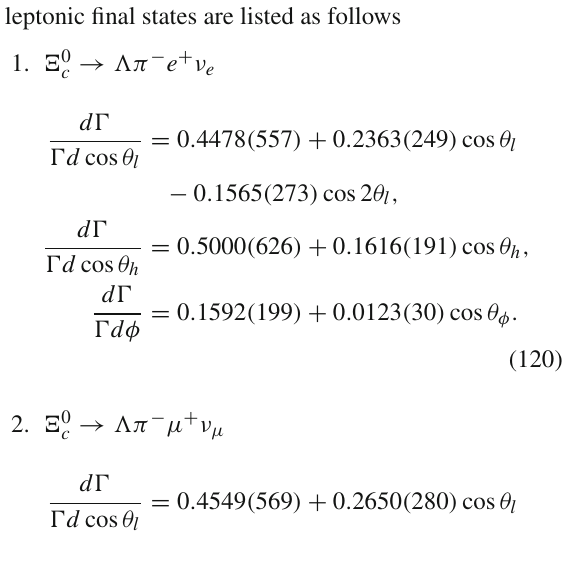
tors extracted from lattice QCD, and its behavior is the → p π − (cid:2) + ν (cid:2) . The results of the θ same as (cid:4) + c